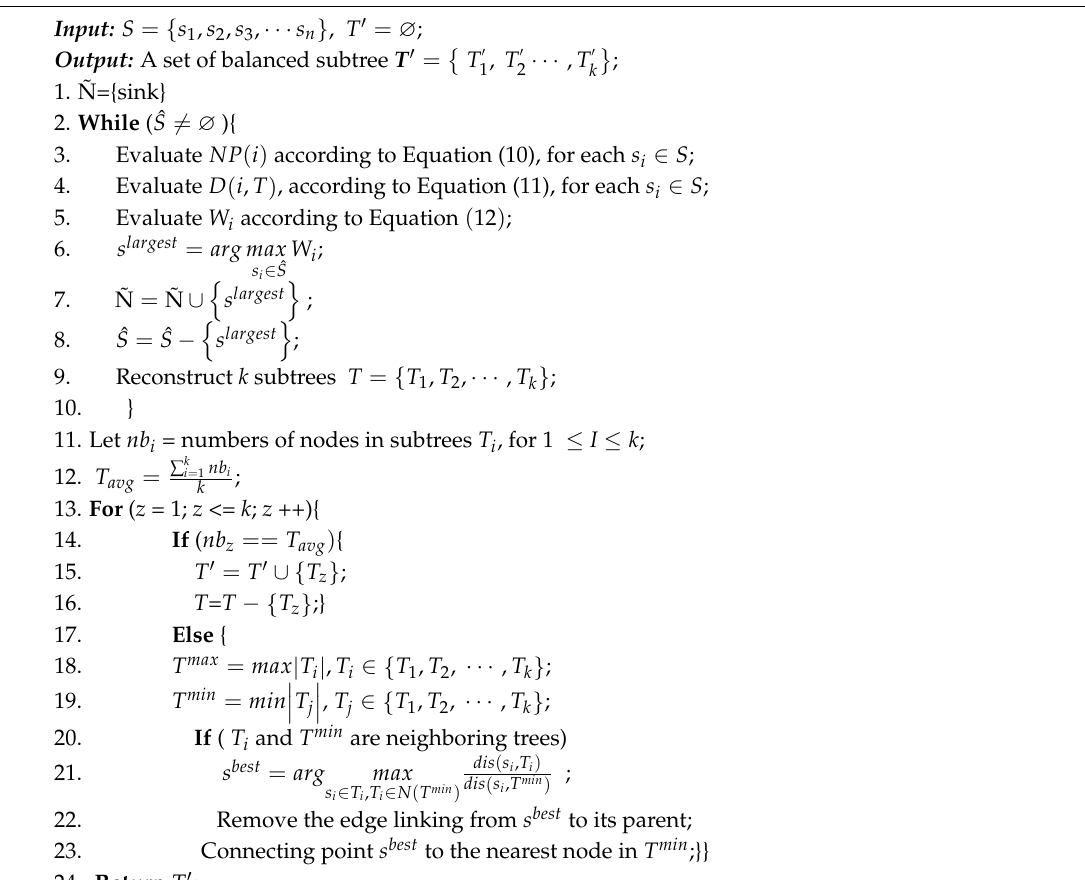
Algorithm 1 . Balanced Tree Partition ( BTP )